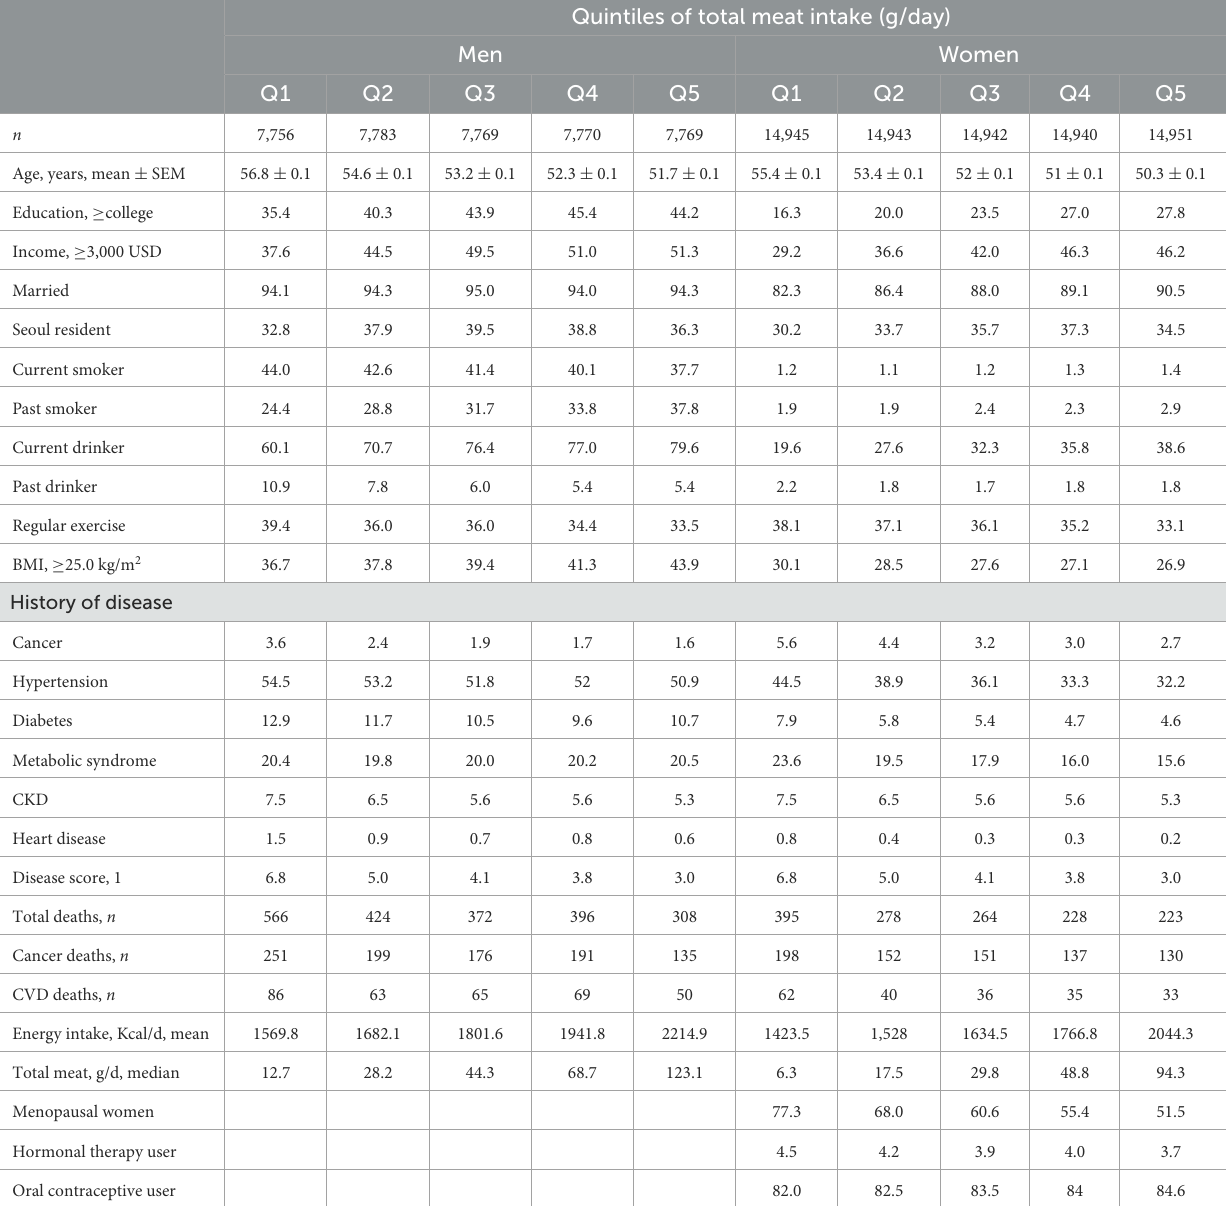
TABLE 1 General characteristics of participants according to quintiles of total meat intake in the HEXA-G